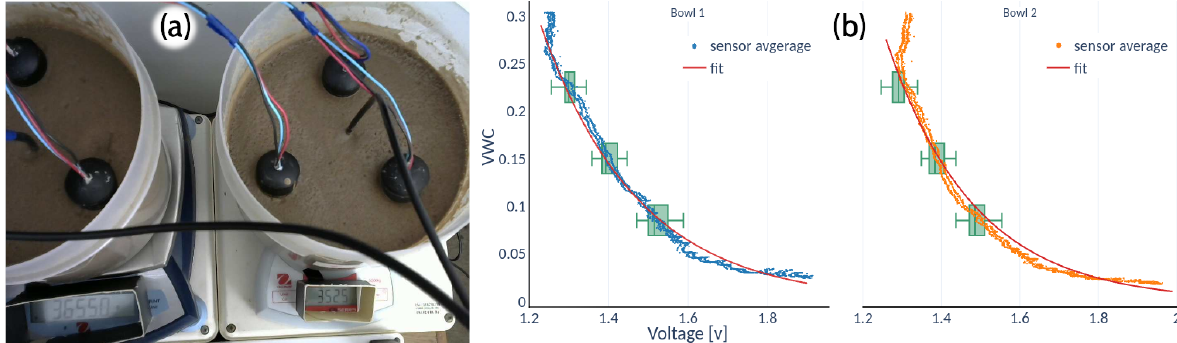
Figure 6. ( a ) Acquisition of real-time data during a soil-drying test. ( b ) Collected data in the lab vs average voltage reading of the coplanar SKU:SEN0193 sensors and its fitted curves (bowl 1: y = 43.23 e − 4.07 v , bowl 2: y = 77 e − 4.47 v ).